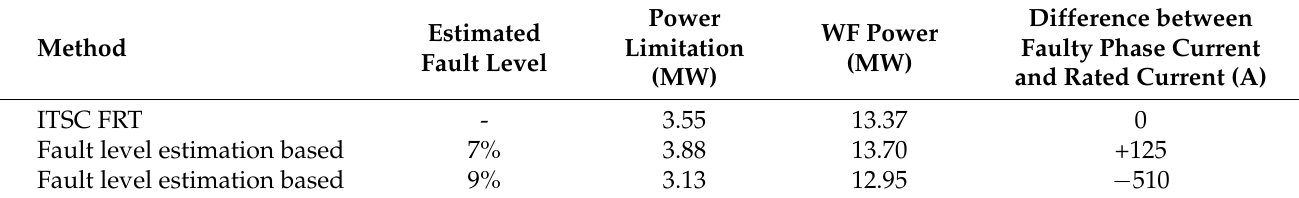
Table 4. Comparison between ITSC FRT and the method based on fault level